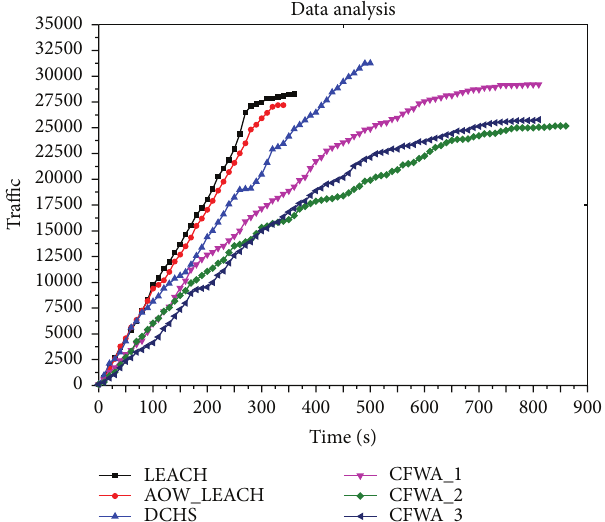
Figure 12: Energy analysis chart between CFWA family algorithms and LEACH-like algorithms in 500